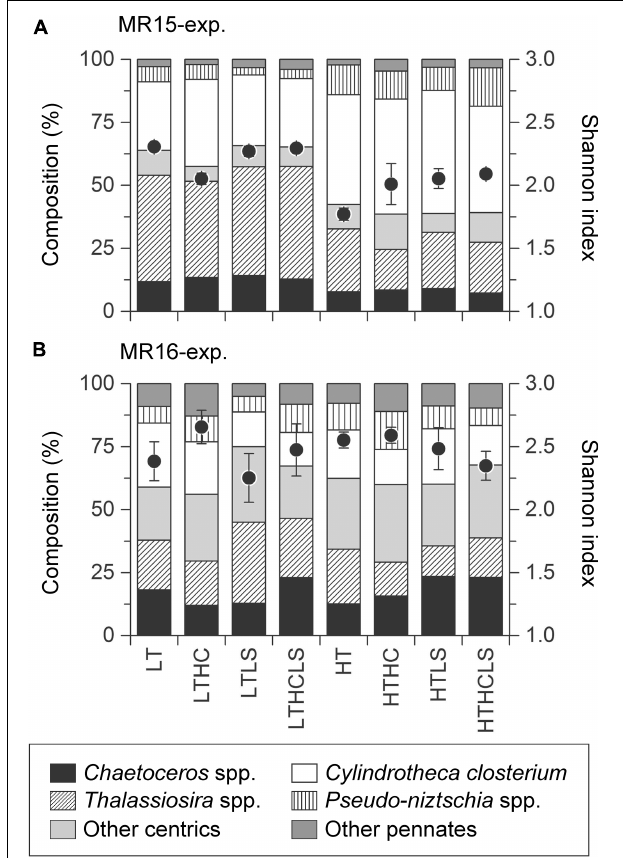
FIGURE 4 | Community composition and diversity index of diatoms in (A) the MR15-exp. and (B) the MR16-exp. during the exponential growth phase. Black circle and error bars represent the mean of Shannon index and error range or 1SD of duplicate (MR15-exp.) or triplicate (MR16-exp.)